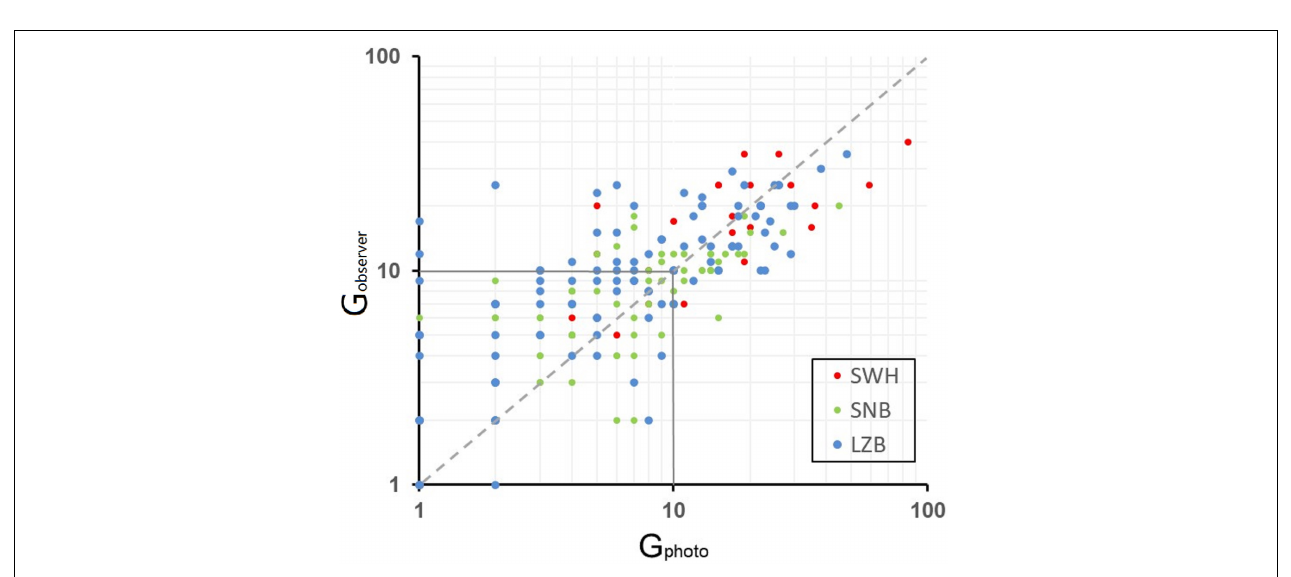
FIGURE 3 | Frequency histograms of humpback dolphin group size in the (A,B) SWH, (C,D) SNB, and (E,F) LZB.G observer : observer-based counts, G photo : photo-identification estimates.